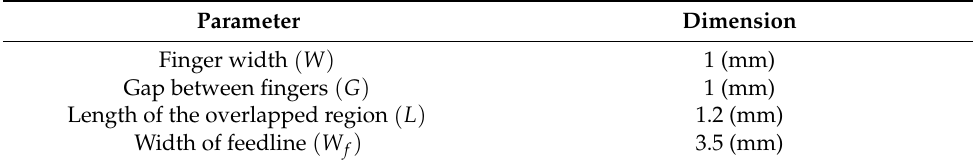
Figure 1. ( a ) Top view and ( b ) cross-section view of the integrated capacitor. Table 1. Final structural dimensions of the proposed